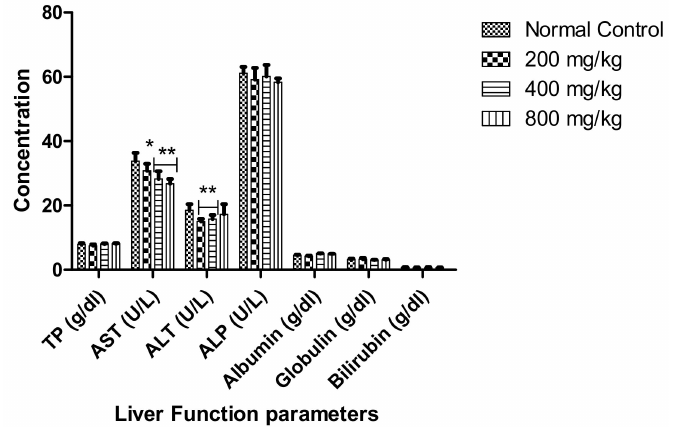
Figure 3. Effect of aqueous C. pepo leaf extract on liver function parameters of male rats. Val- ues represent the mean ± SD for n = 6. * indicates significance at ( p < 0.05) and double asterisk (**) indicates significance at p < 0.01. TP, Total Protein; AST, Aspartate Aminotransferase; ALT, Alanine Transaminase; and ALP, Alkaline Phosphatase.